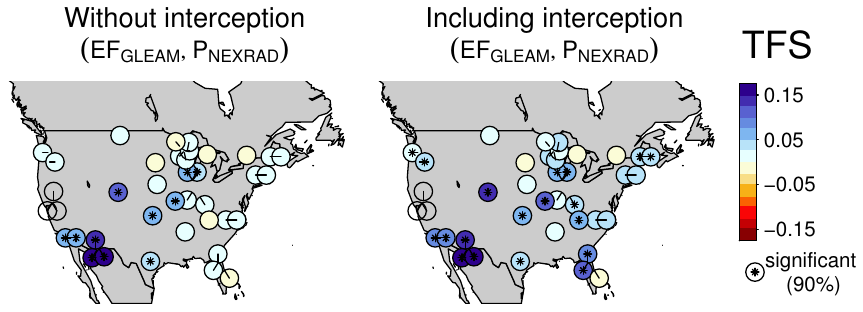
Figure 11. Influence of interception evaporation on TFS ∗ in the GLEAM–NEXRAD combination. Left: interception is not included in the EF computation. Right: interception is included in the EF computation and EF is then capped at 1. Values significantly different from 0 at the 90% level are indicated by a black asterisk. Empty dots indicate sites with unreliable NEXRAD data.